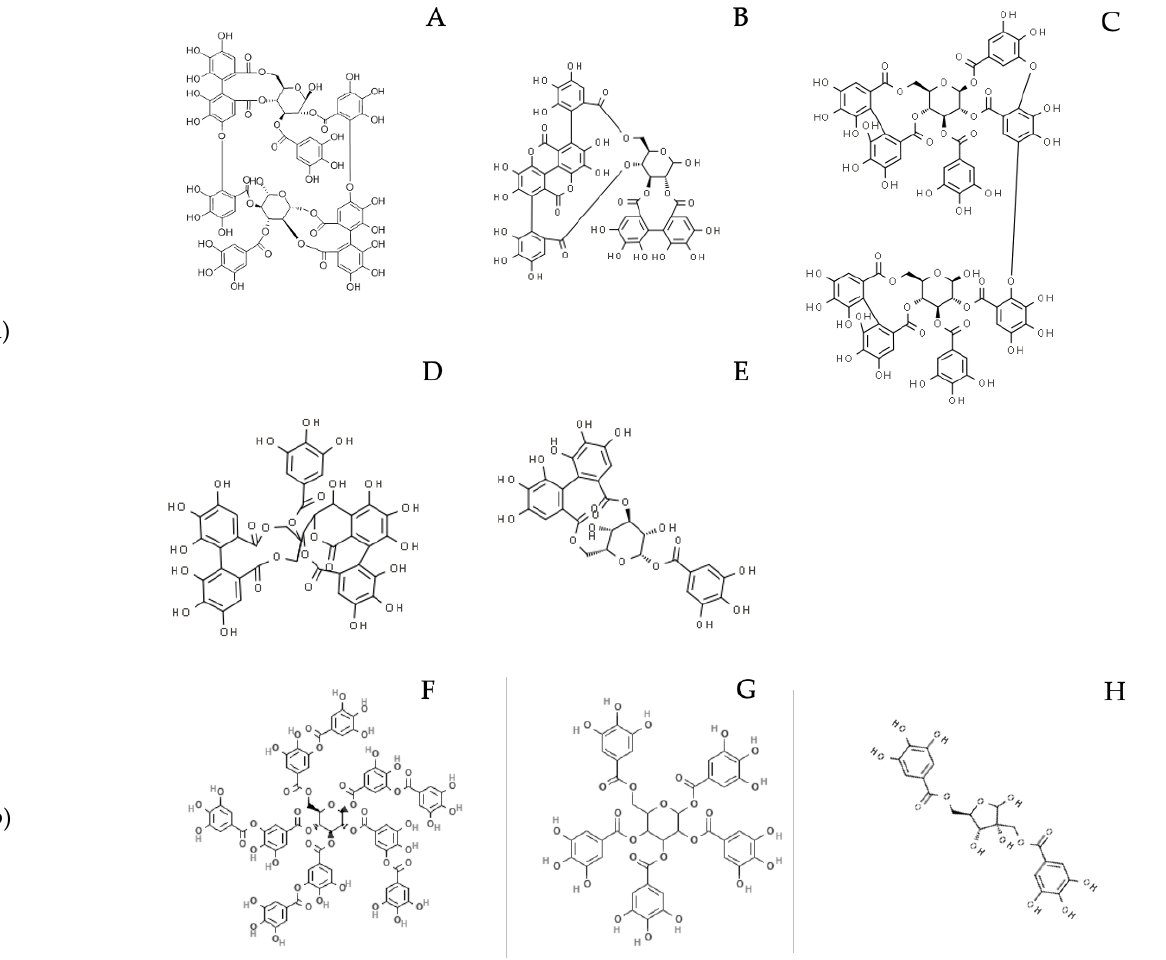
Figure 1. ( a ) Examples of ellagitannins cited in the main text: A. Oenothein B; B. Punicalagin; C. Tamarixinin A; D. Casuarinin; E. Corilagin. ( b ) Examples of gallotannins cited in the main text: F. Tannic acid; G. 1,2,3,4,6 Pentagalloyl glucose; H. Hamamelitannin.